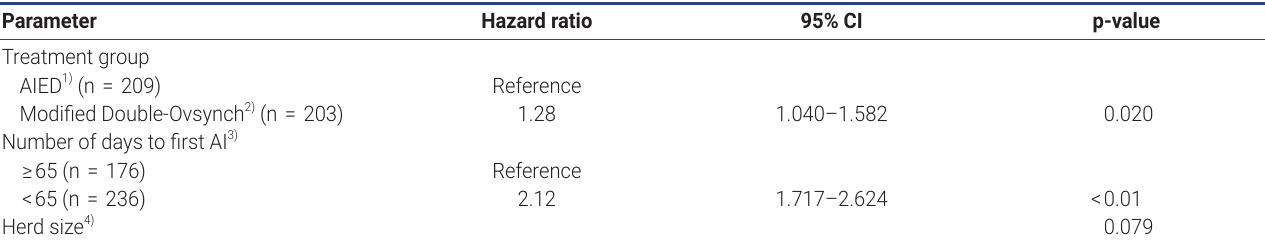
Table 3. Factors affecting the likelihood of pregnancy of Hanwoo cows by 150 days postpartum, analyzed using the PHREG procedure